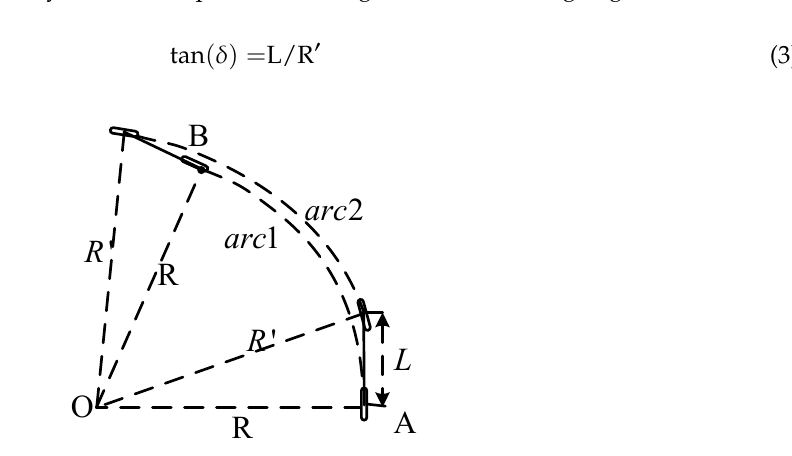
Figure 3. Extended kinematic bicycle model.